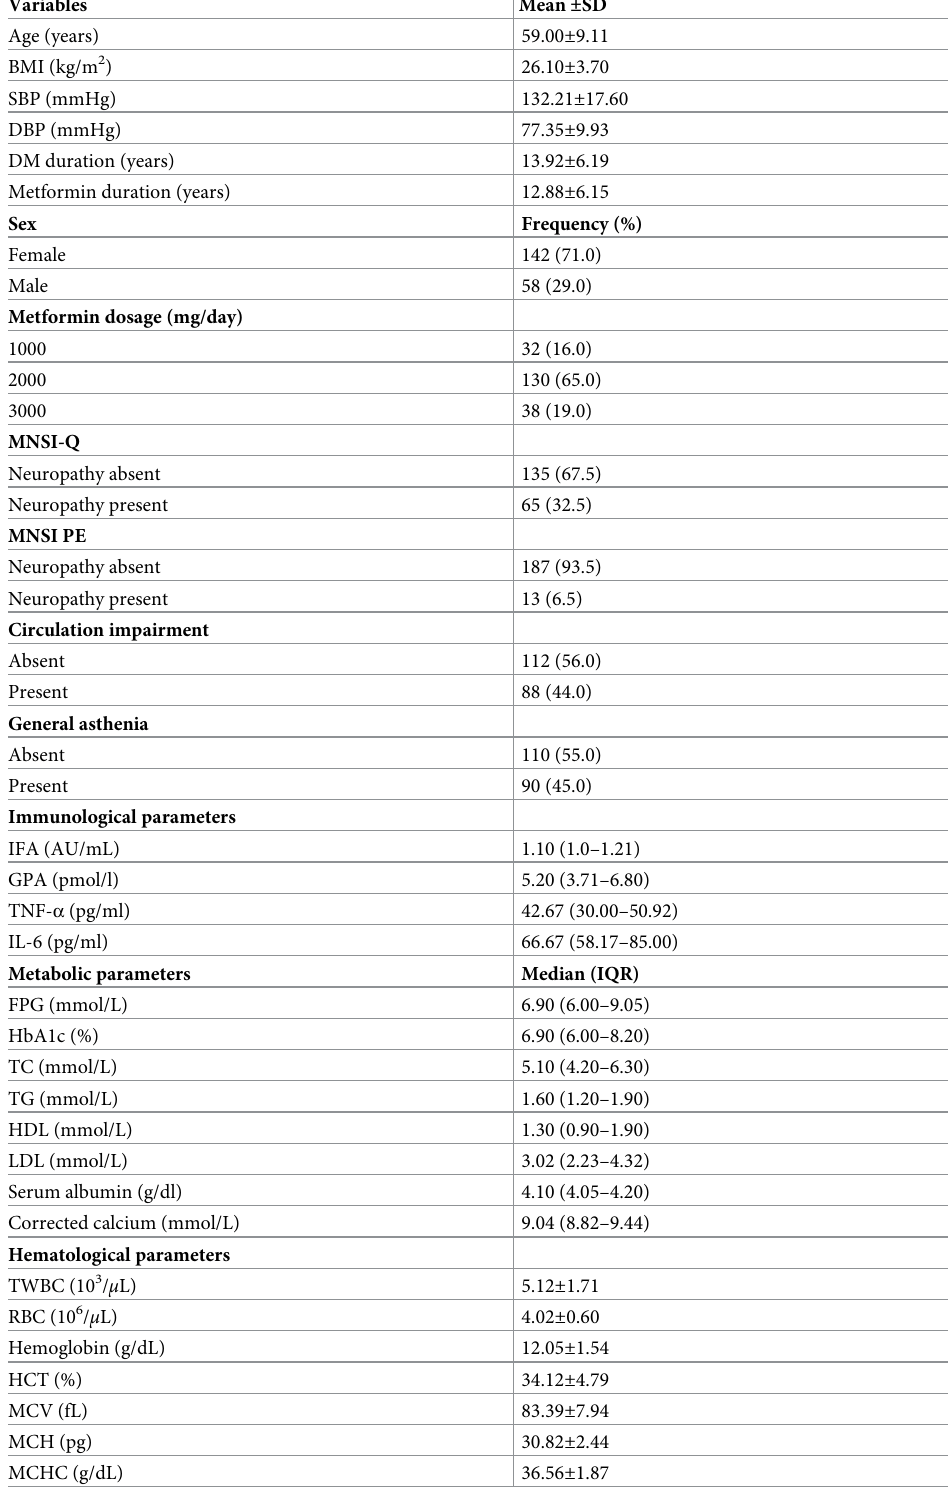
Table 1. Demographic, clinical and immune-metabolic profile of the entire study